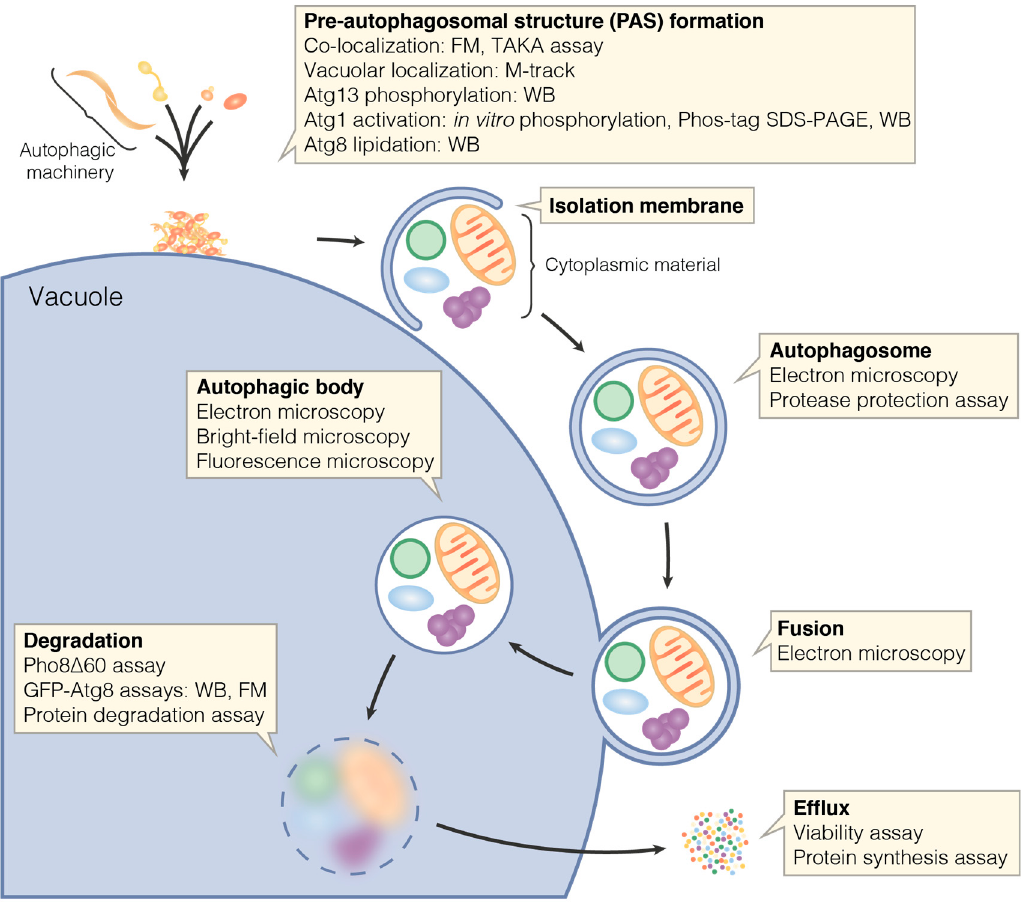
Figure 1. Methods for studying individual steps of bulk autophagy. Bulk autophagy and selective types of autophagy largely rely on the same core machinery. Many of the assays depicted up to vacuolar degradation are also useful for studying selective autophagy—see text for details. FM: fluorescence microscopy; WB: Western blotting.